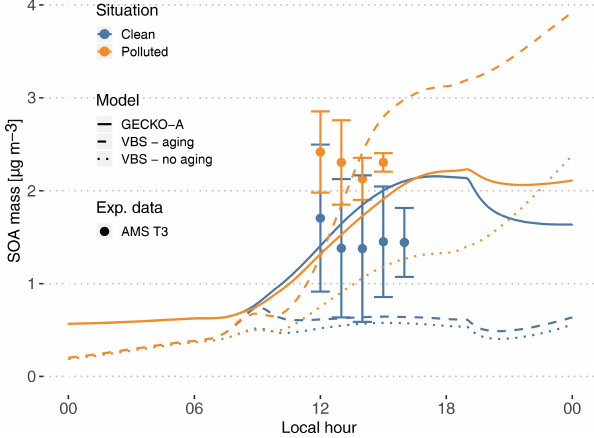
Figure 7. Experimental (circles, T3 site) and modeled (lines, second day) time evolution of SOA mass concentration. The vertical range of the experimental data denotes the standard deviation of measured concentrations. Cases are identified as clean (blue) and polluted (or- ange). The continuous lines depict the GECKO-A model run, and the dashed lines depict the modeled SOA mass predicted with the VBS approach from Shrivastava et al. (2019). The dotted lines de- pict modeled SOA mass predicted with the VBS approach without including aging processes (see Sect.